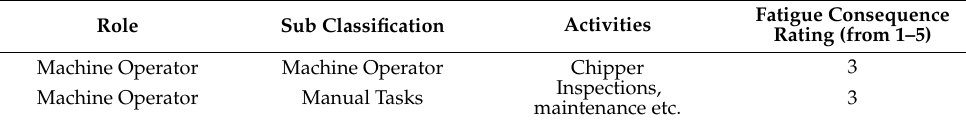
Table 1. Chipper operator fatigue rate during operation and maintenance